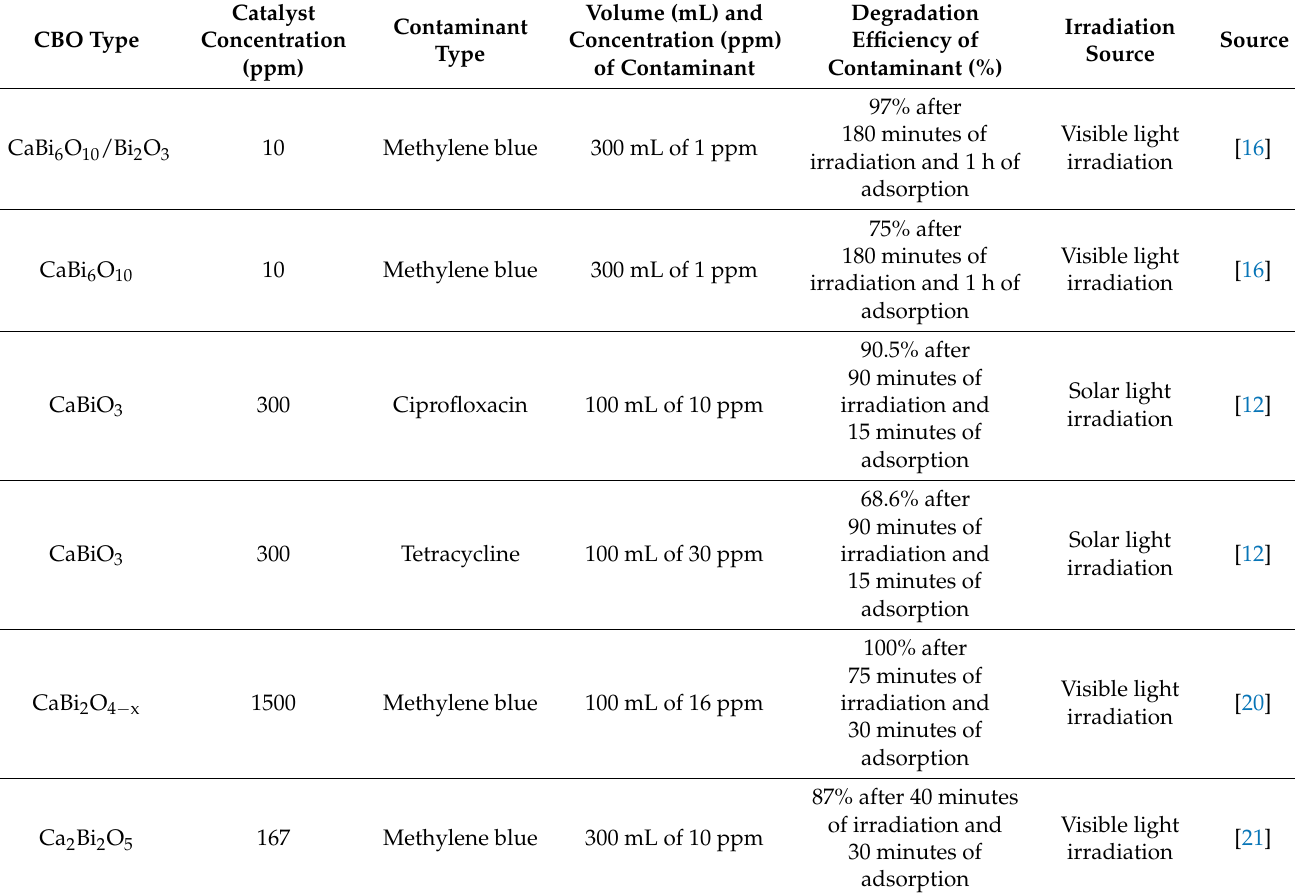
Table 1. Scientific literature review for photocatalytic degradation of various contaminants over CBO